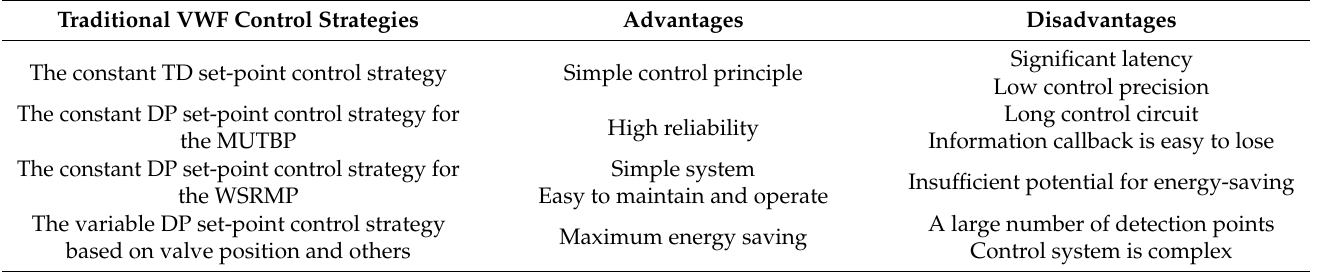
Table 1. Advantages and disadvantages of traditional VWF